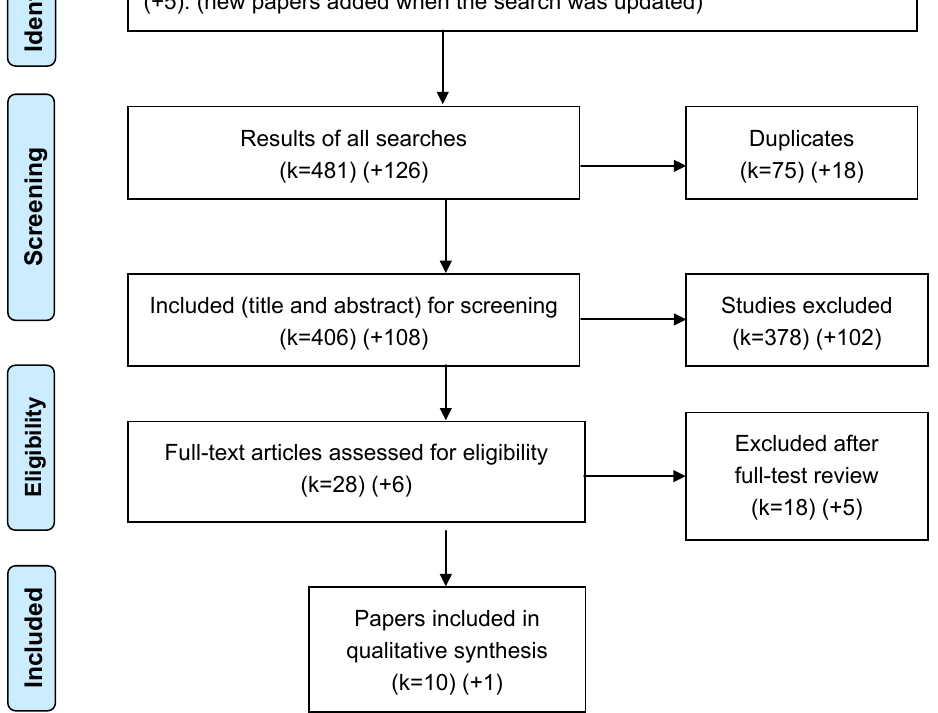
Figure 1. Items selected for systematic review and meta-analyses (PRISMA). Embase, Excerpta Medica Database; HTA, Health Technology Assessment; Medline, Medical Literature Analysis and Retrieval System Online; NHSEED, National Health Service Economic Evaluation Database. The search was updated in June